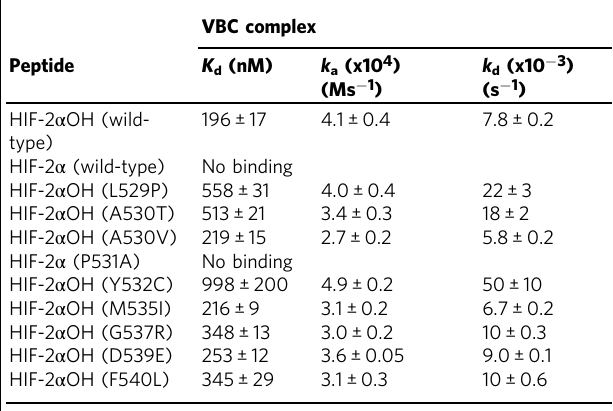
Table 2 Kinetic parameters of HIF-2 α peptides binding to puri fi ed VBC complex